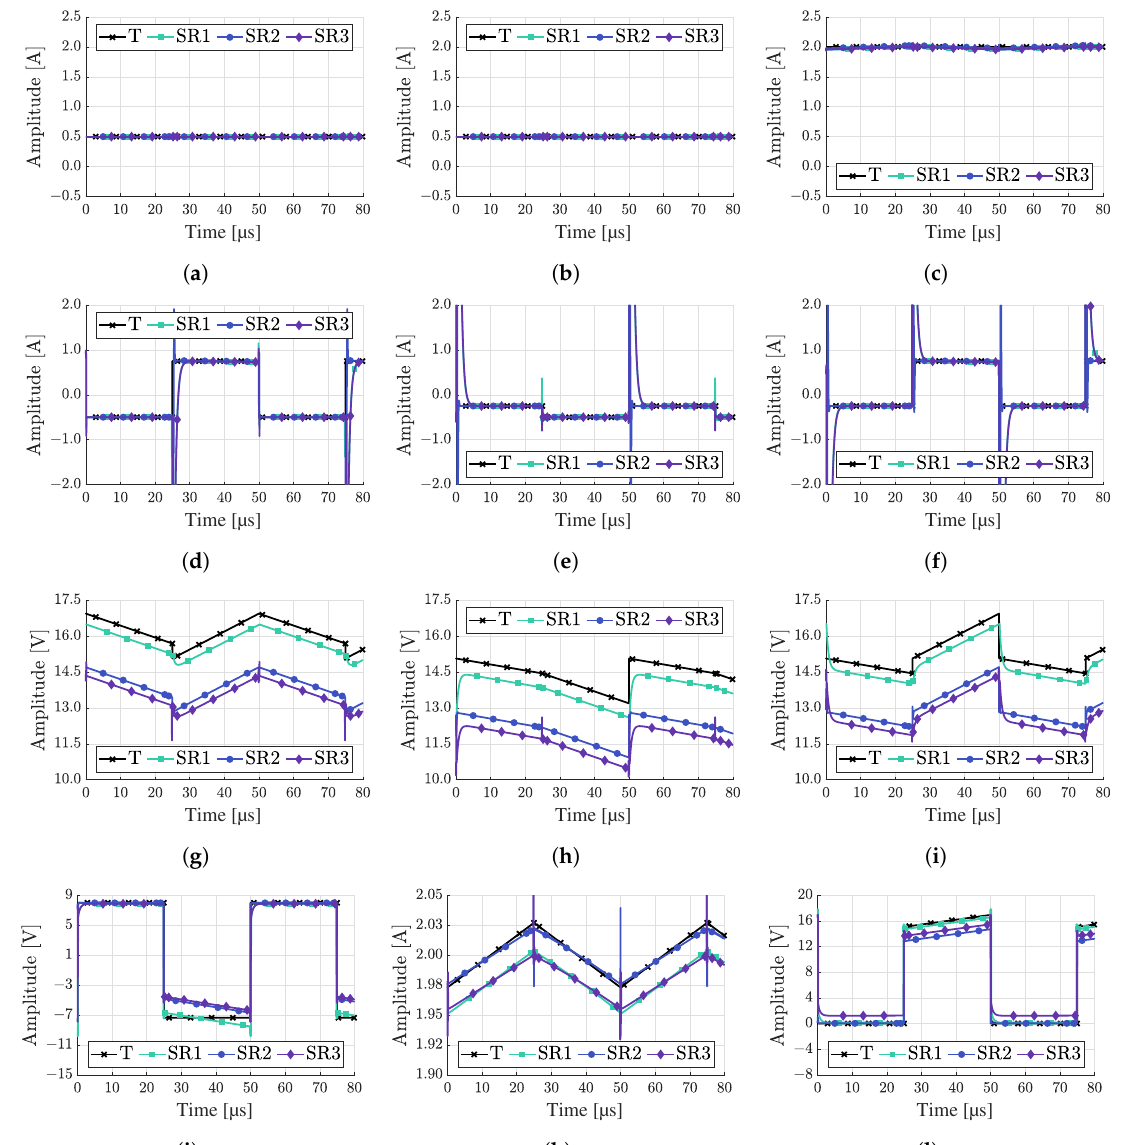
( t ) with B ( t ) ; ( k ) i ( t ) without small L B B